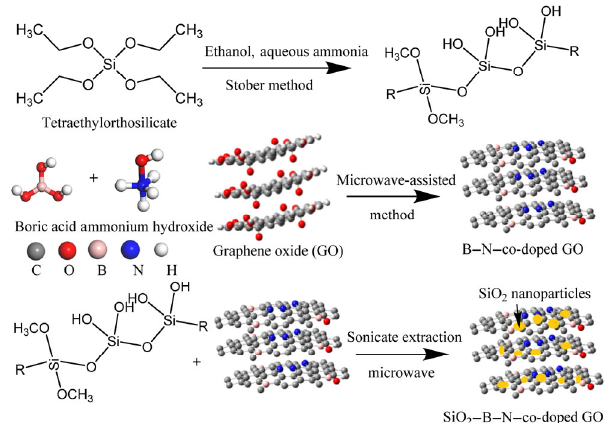
Fig. 1 Schematic diagram of the formation of the SiO 2